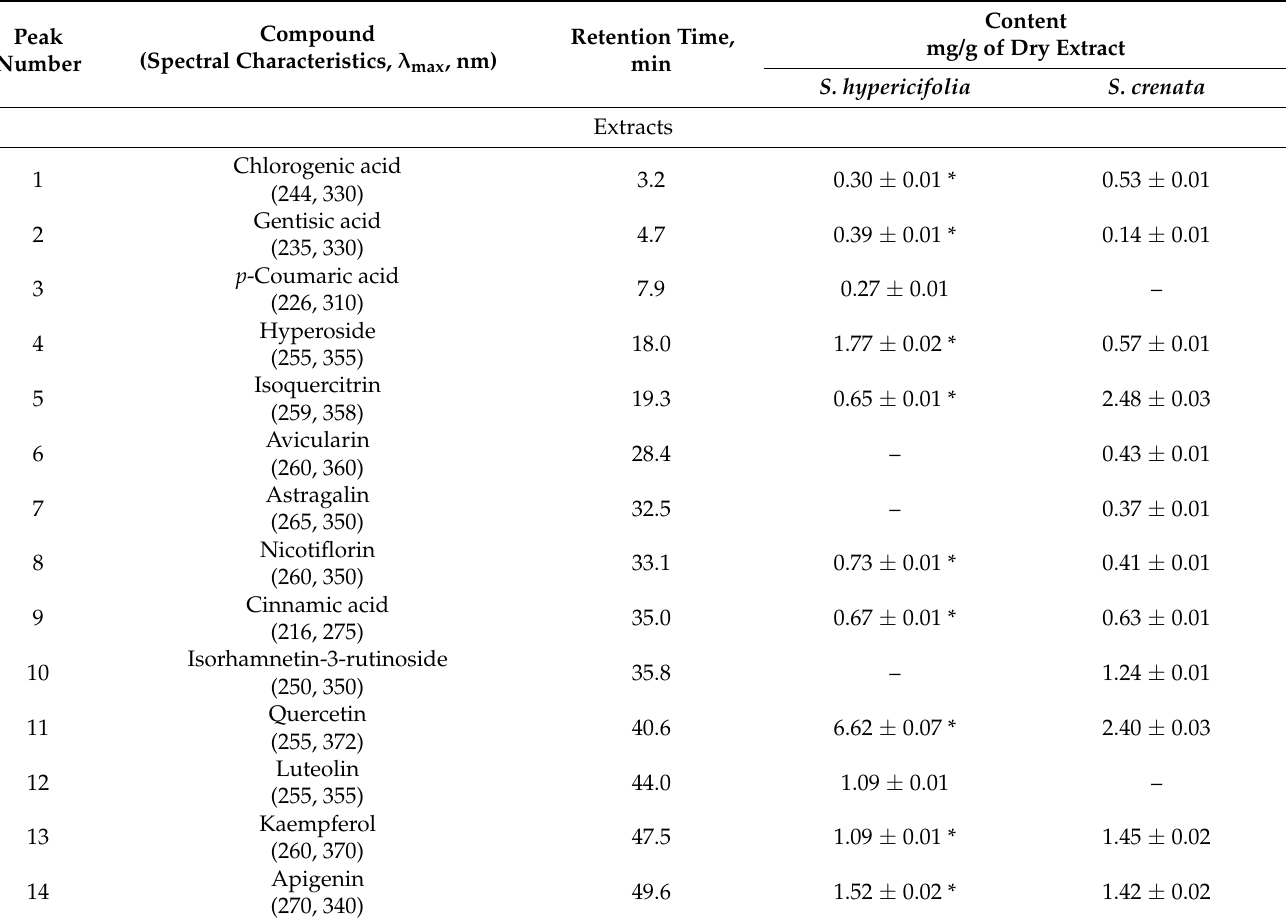
Table 2. Characteristics and contents of phenolic compounds identified by HPLC in extracts from aerial parts of S. hypericifolia and S. crenata